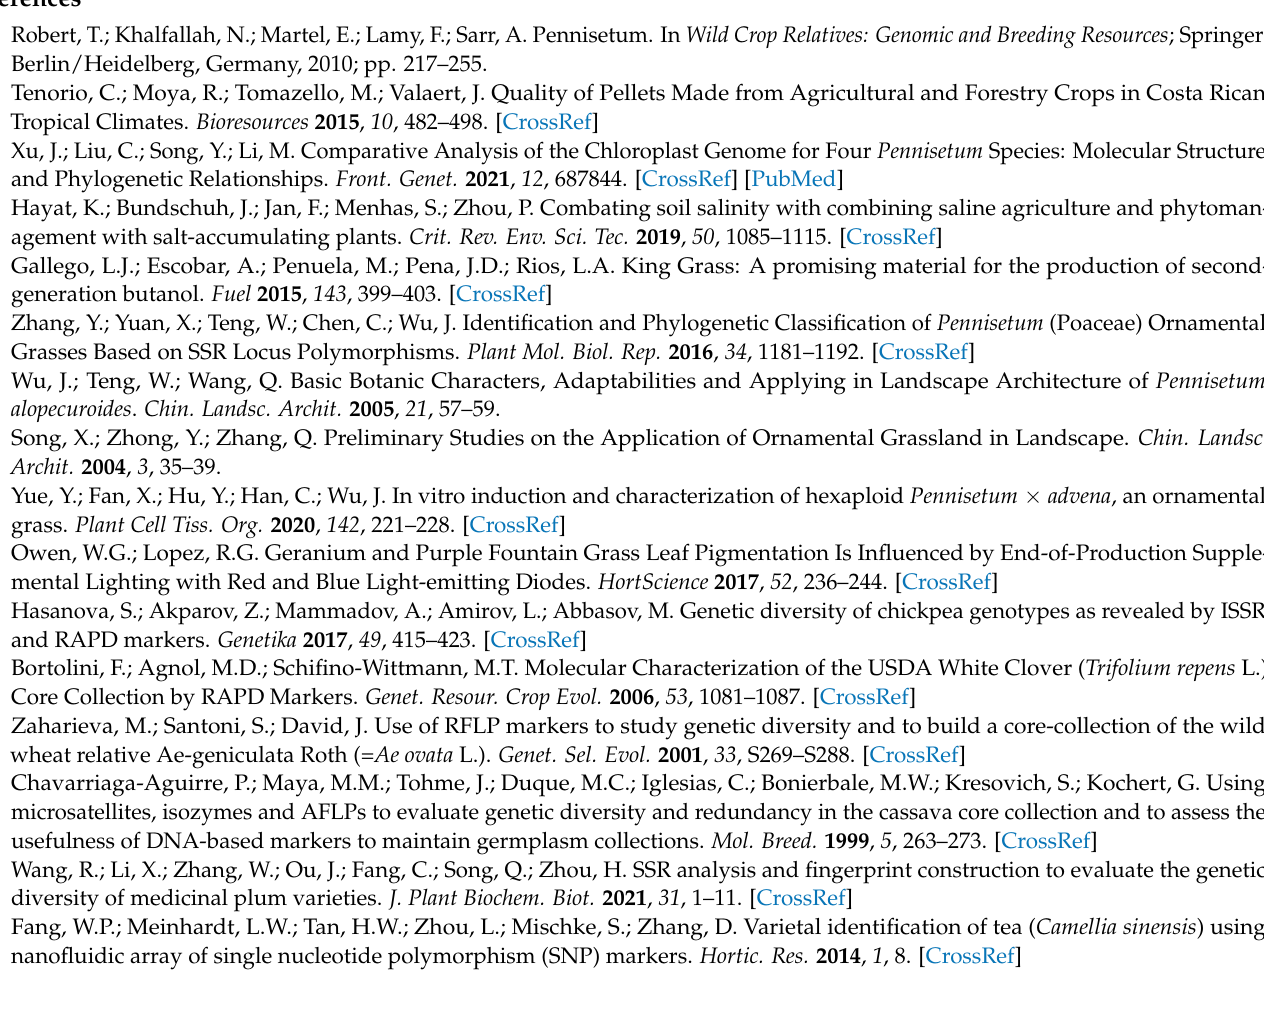
results of Pennisetum varieties coded from 1 to 40; Table S1: Band Statistics Raw Data; Table S2: Genetic diversity parameters of 38 pairs of polymorphic primers in the 38 Pennisetum materials; Table S3: The genetic similarity coefficient between